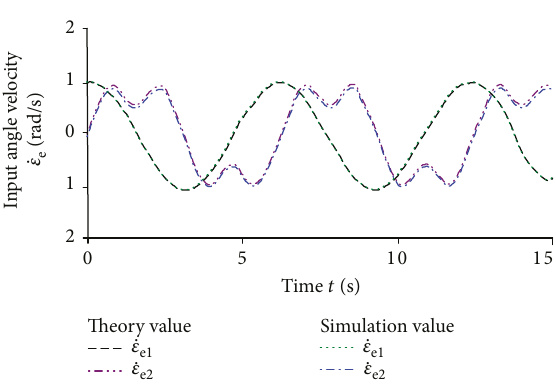
Figure 8: The input angle velocity curve of the elbow